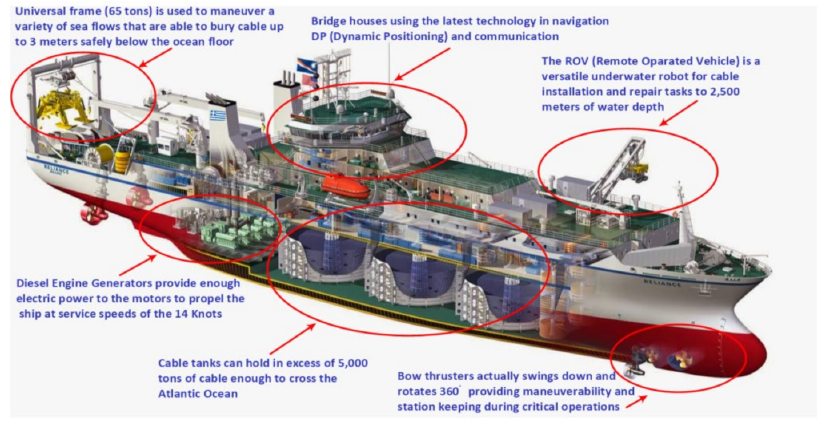
Figure 10. A typical cable ship